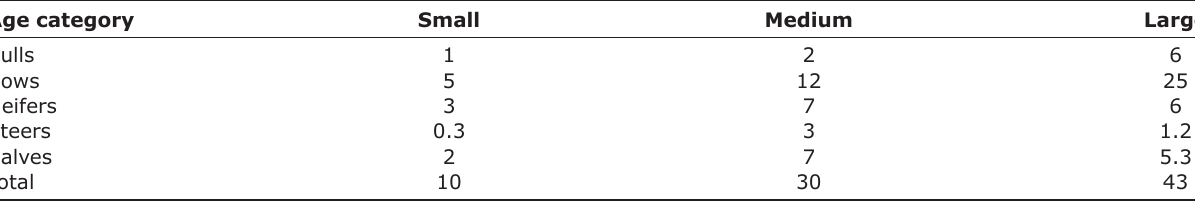
Table-13: Average vaccination costs in US dollars against FMD for all herd categories.